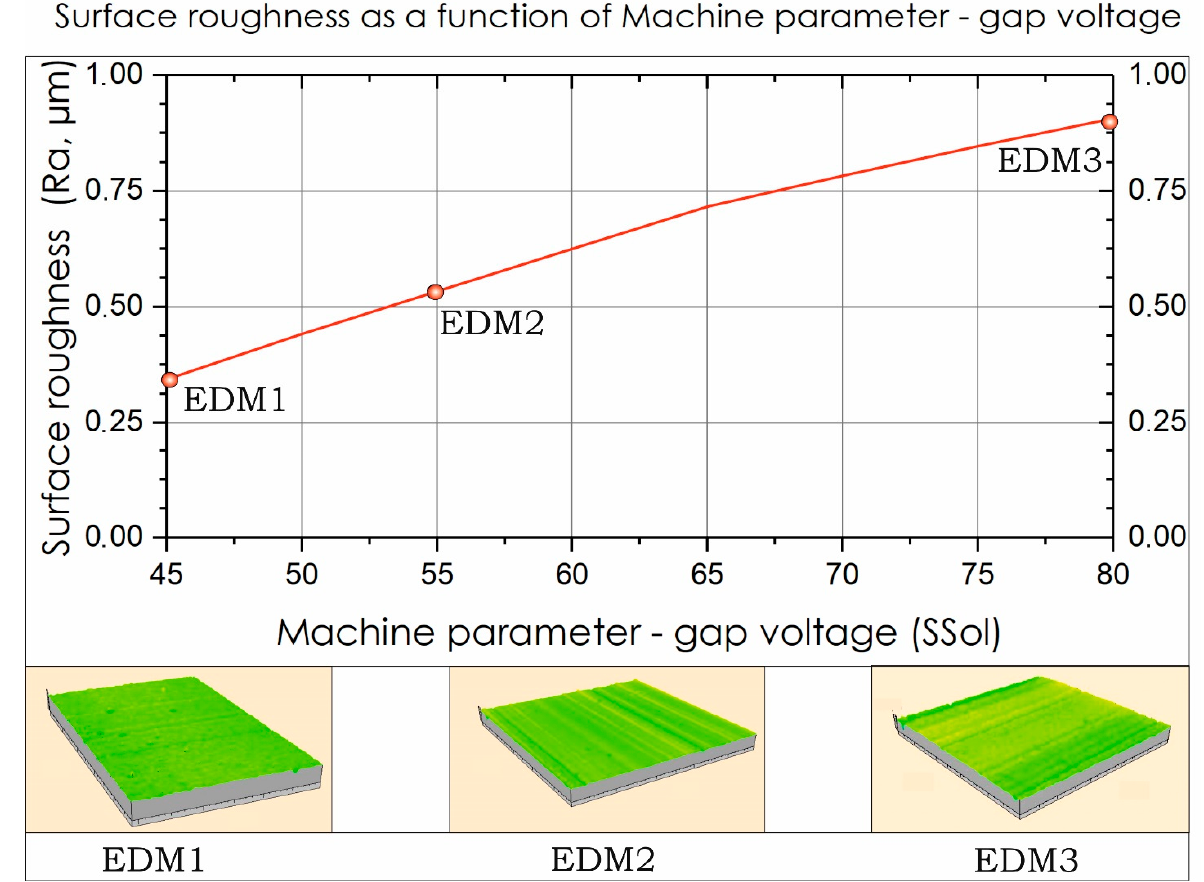
Figure 4. Surface roughness Ra as a function of machine parameter SSol for EDM1 (SSol = 45, Ra 0.344 µm), EDM2 (SSol = 55, Ra 0.534 µm), and EDM3 (SSol = 80, Ra 0.907 µm) measured using the Hommel Tester T8000. 3D images of surface roughness profiles shown in the three lower panels are given for illustration purposes only.